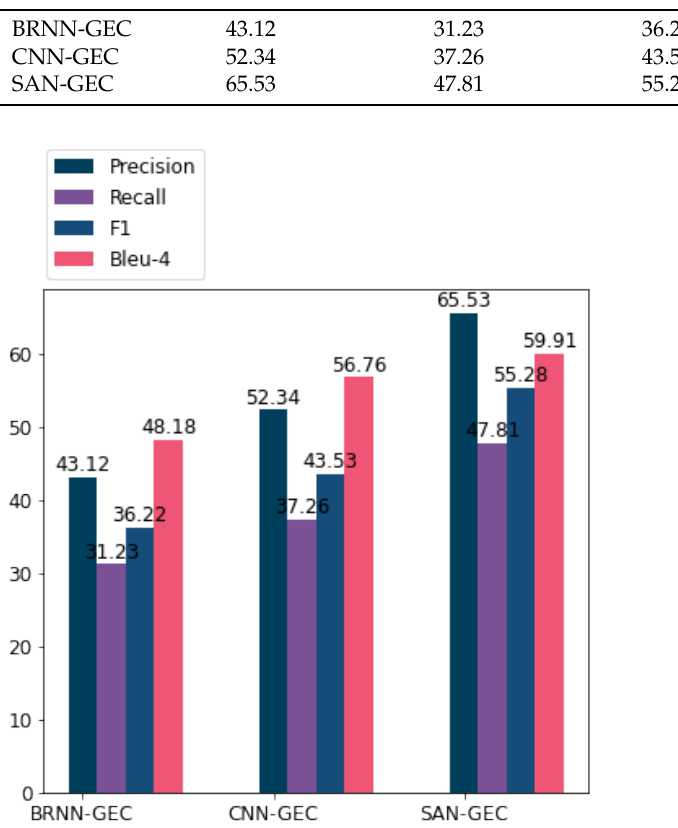
Figure 5. Illustration of the performance of the three baselines using our synthetic